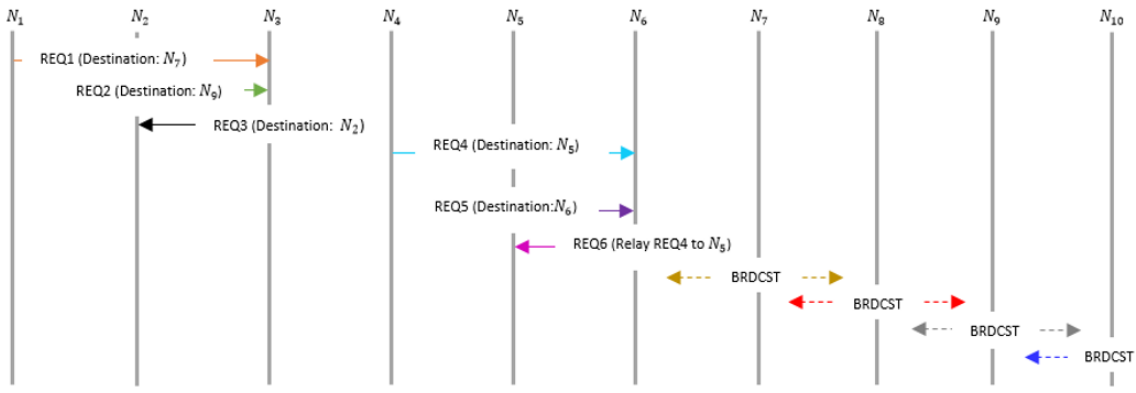
Figure 9. Flow graph of transmission of first control frame messages for N nodes, where N = {1, 2, 3, ... ,